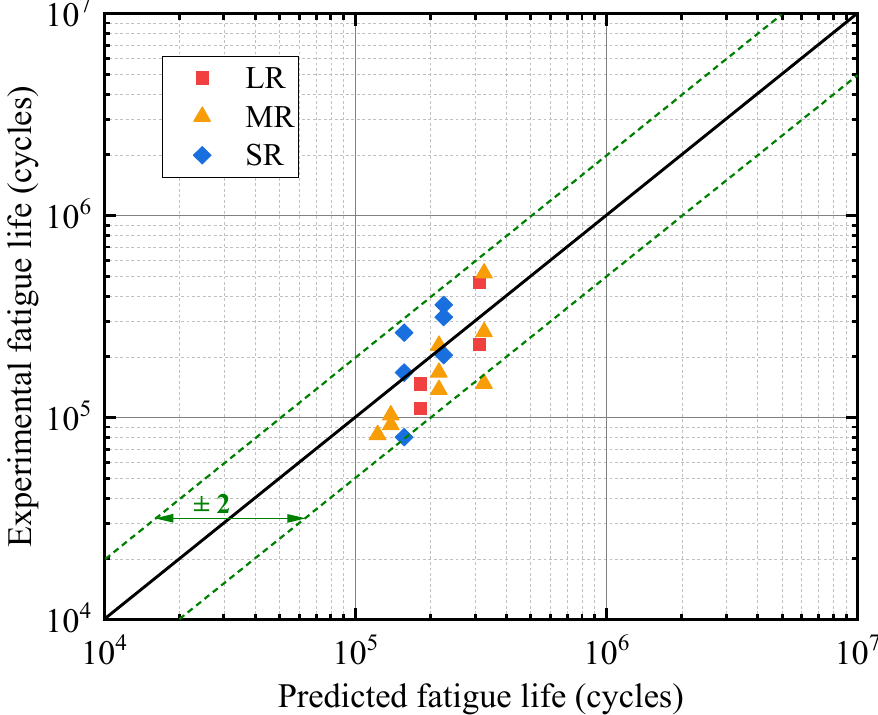
Figure 12. Predicted total fatigue life versus experimental life.